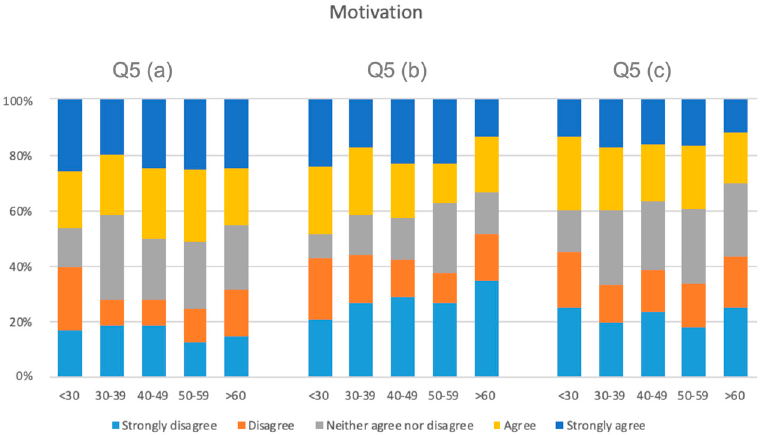
Figure 10. Motivation in Facebook Group (Q5) age analysis.